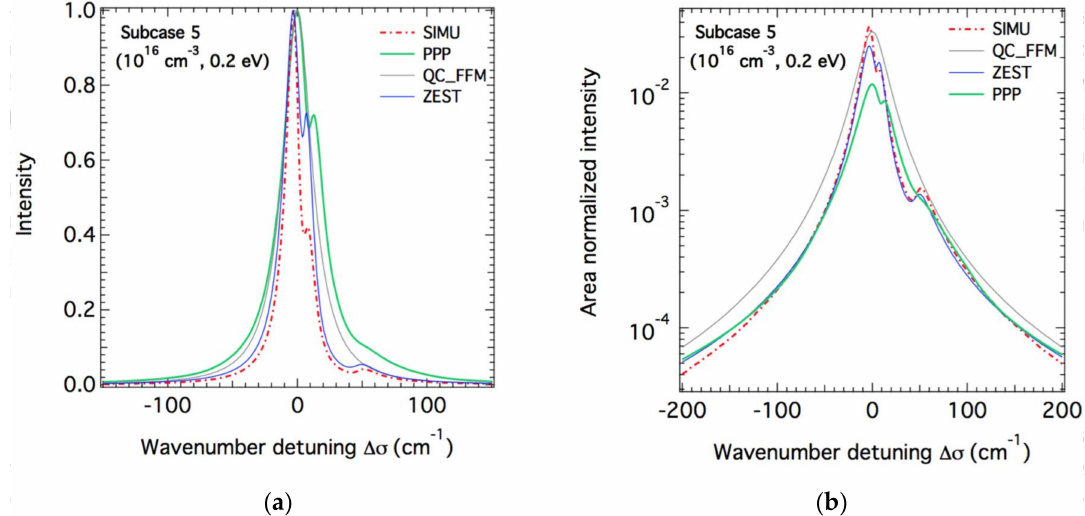
Figure 5. Same as Figure 4, but for T e = T i = 0.2 eV. Same line styles and code colors as Figure